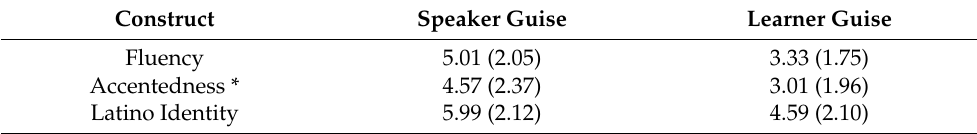
Table 1. Descriptive statistics by guise type for each